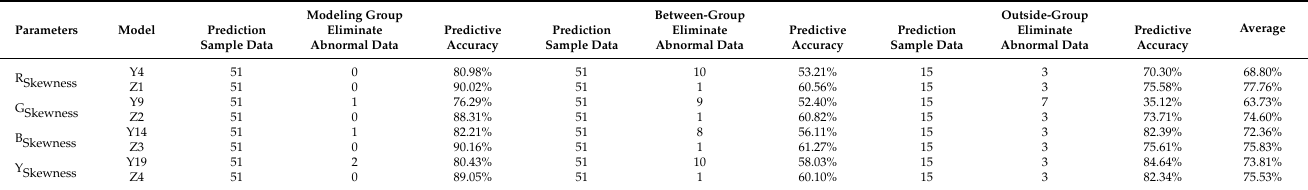
Table 6. Comparison of the prediction accuracy of the multiple stepwise regression models and spatial bidirectional models for the